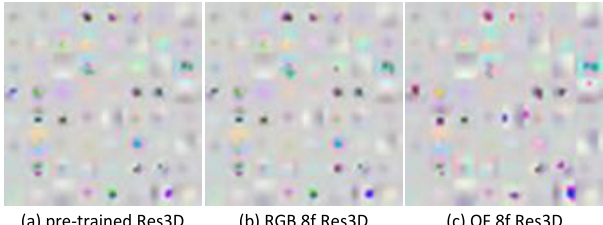
Figure 10. Visualization of the Conv1 feature maps. Res3D captures the appearance information in the first frame of the clip and thereafter captures the motion information.